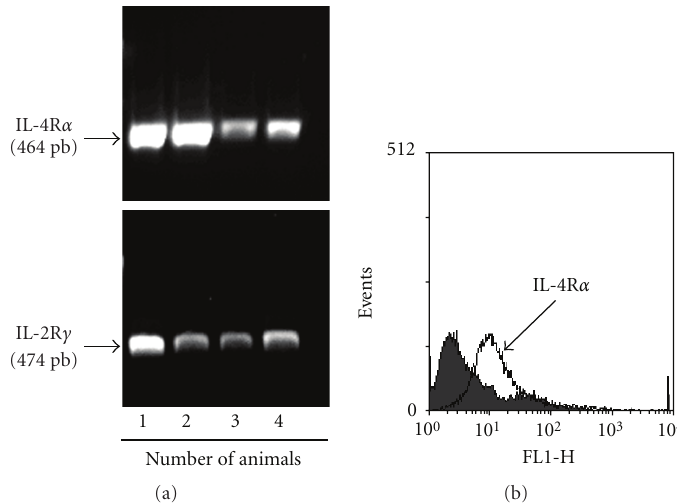
Figure 4: The murine air pouch resident lining cells express the IL-4 receptor . Air pouches were created and lining cells were harvested as described in Materials and Methods. IL-4R α chain was detected by RT-PCR (a) and by flow cytometry (b) using a specific antibody directed against murine IL-4R α . Note that IL-4R α mRNA was detected at variable levels in all tested animals, as well as IL-2R γ . Only four di ff erent animals are presented (nos. 1–4). The receptor was detected on the cell surface of the lining cells. Results are from one representative experiment out of